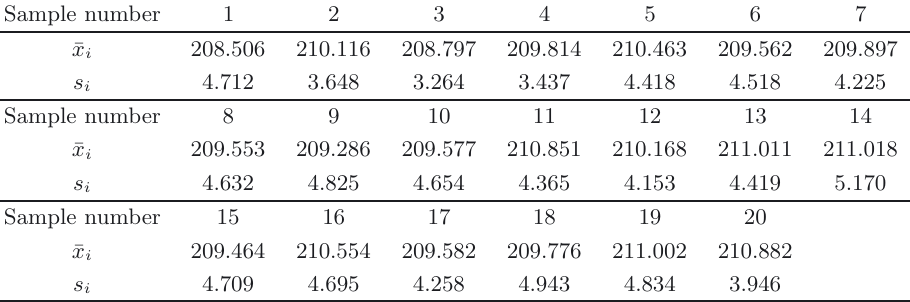
Table 1. Means and standard deviations of the 20 subsamples.